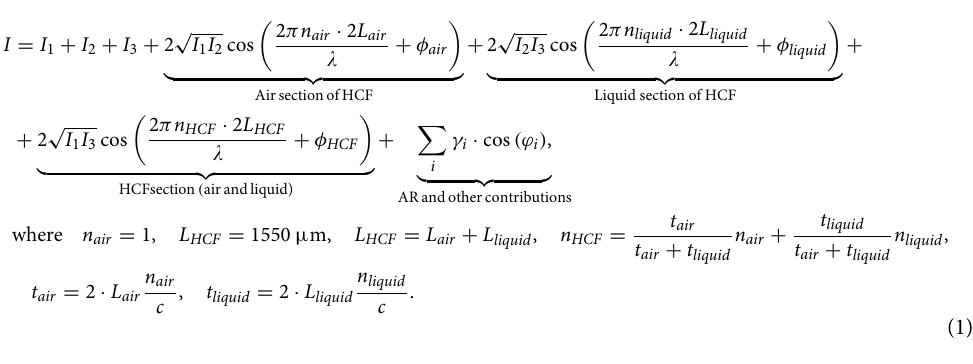
Figure 4. Schematic explanation of the manufactured sensor, with the interferometric contribution of the different Fabry–Perot cavities: air section, liquid section and both